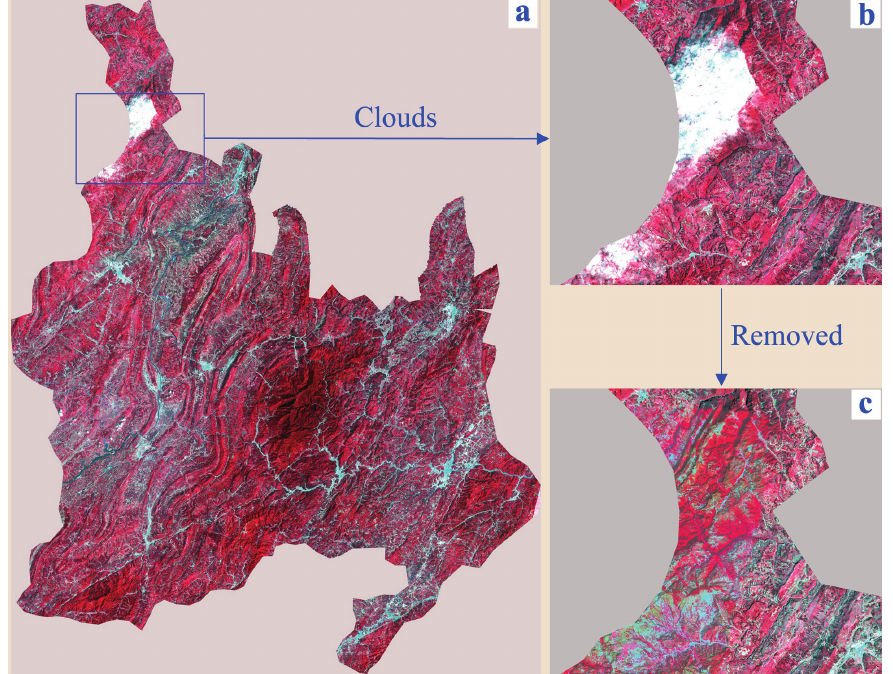
Figure 2 - The results of the region and removal of clouds in 2016, clouds location ( a ), images before ( b ) and after ( c ) clouds